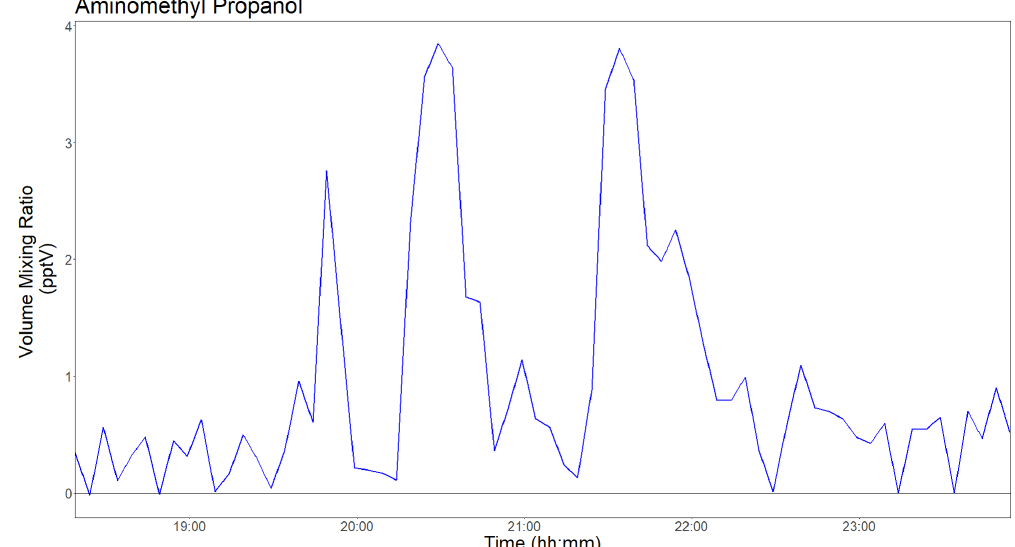
Figure 8. Time series (5min averages) of 2-amino-2-methylpropan-1-ol (AMP) as measured at Sande, 4.4km downwind of the TCM CO 2 capture plant. A steady level of ∼ 1ppmv of AMP was released from the stack during the measurement period, which resulted in single-digit pptv enhancements of AMP at the downwind